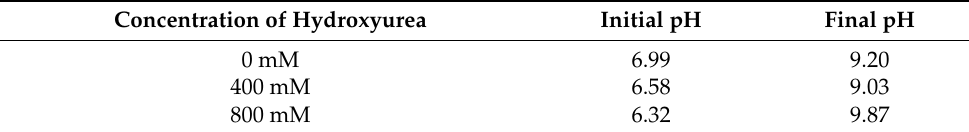
Table 1. pH measurements of starting concentration for the synthesis.